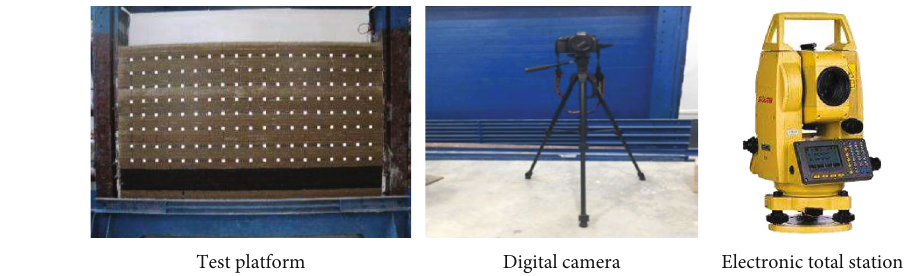
Figure 4: Measuring and record equipment. Table 1: Similar parameters of the test model. Similar